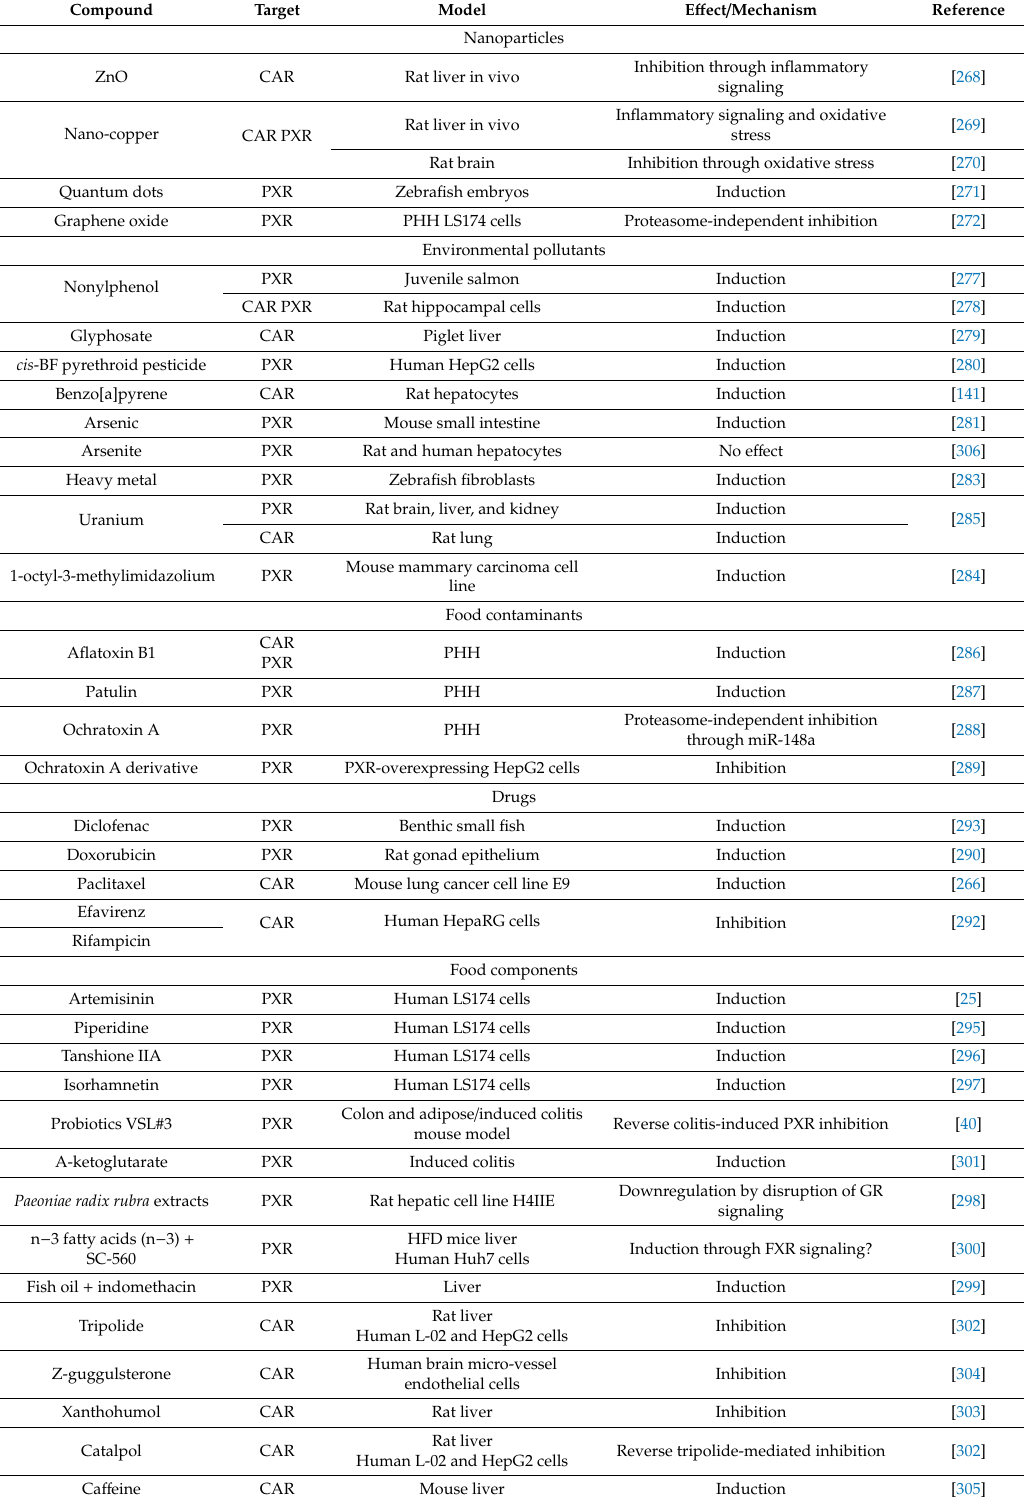
Table 4. Xenobiotics that a ff ect CAR and PXR